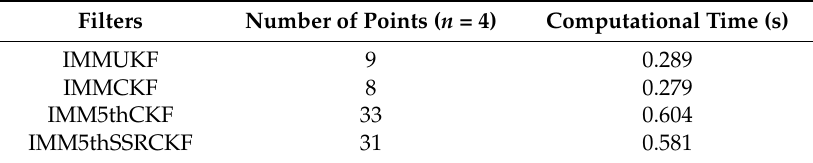
Table 2. Number of points and computational time of different algorithms.